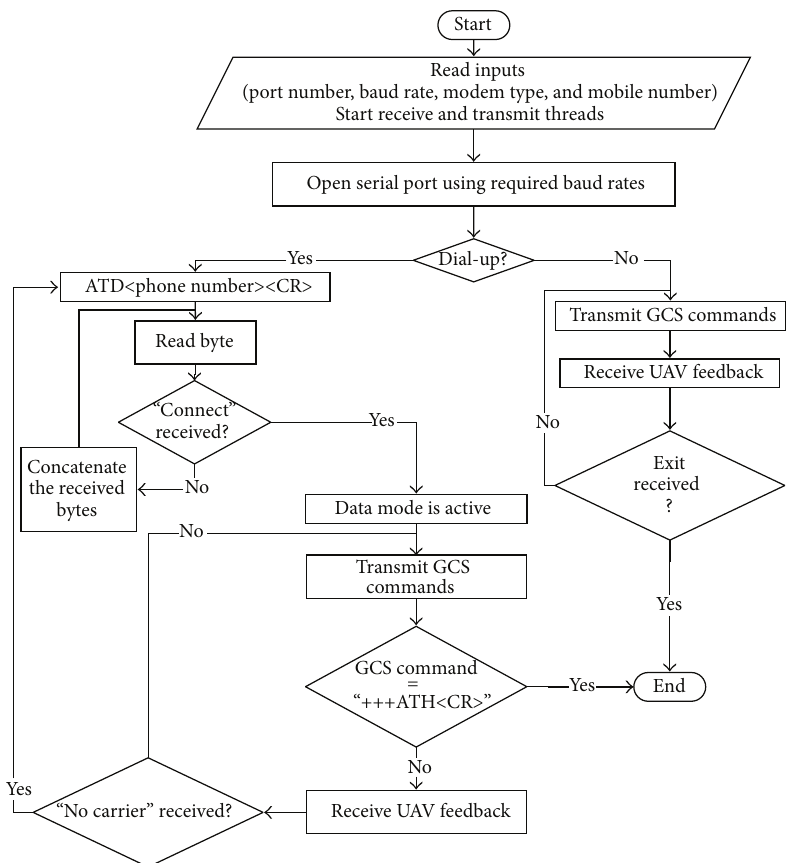
Figure 9: Detailed flowchart of GSM interface